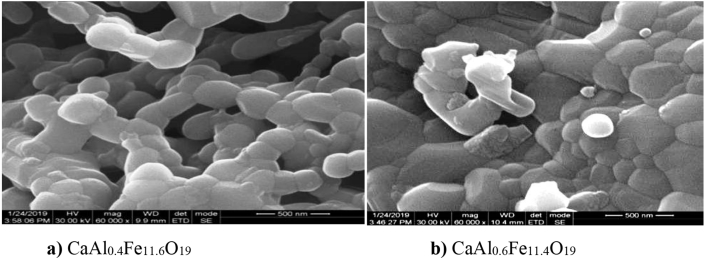
FE-SEM micrographs of calcium hexaferrite a) Ca Al0.4Fe11.6O19 b) CaAl0.6Fe11.4O19.